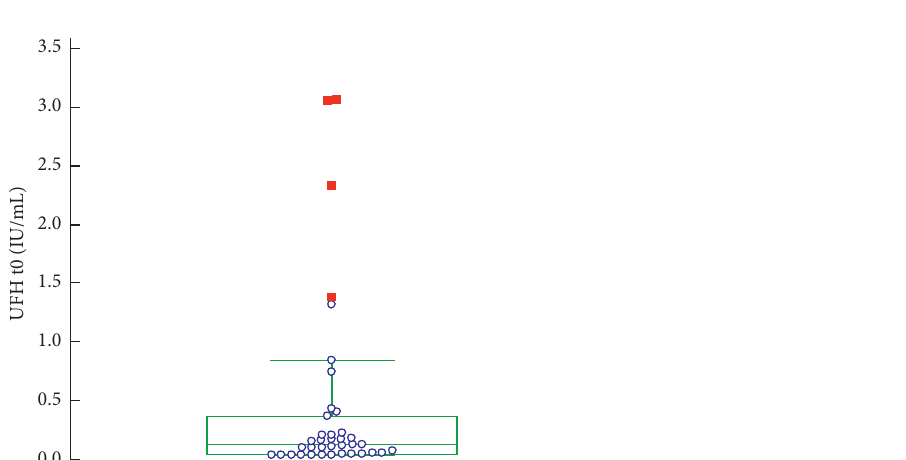
Figure 1: Box and Whisker plot UFH concentrations at the start; red squares represent far out values ( > upper quartile +3 times the interquartile range).